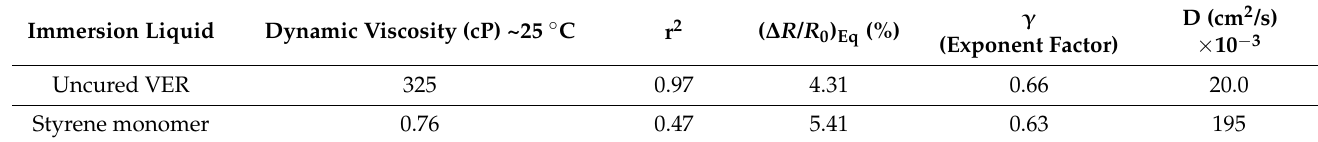
Table 5. Viscosities and average fitting parameters of Equation (1) after immersion in uncured VER and styrene monomer. Immersion Liquid Dynamic Viscosity (cP) ~25 ◦ C Uncured VER 325 Styrene monomer